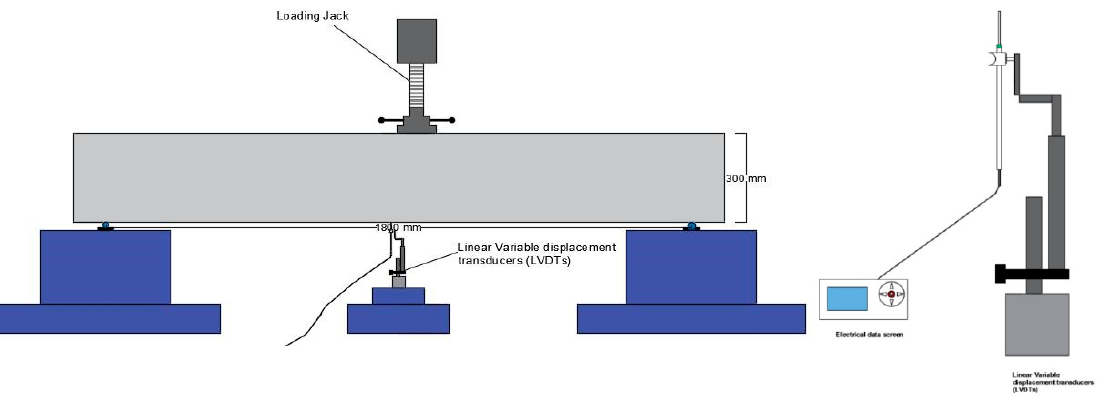
Figure 5. Test setup and LVDTs device.